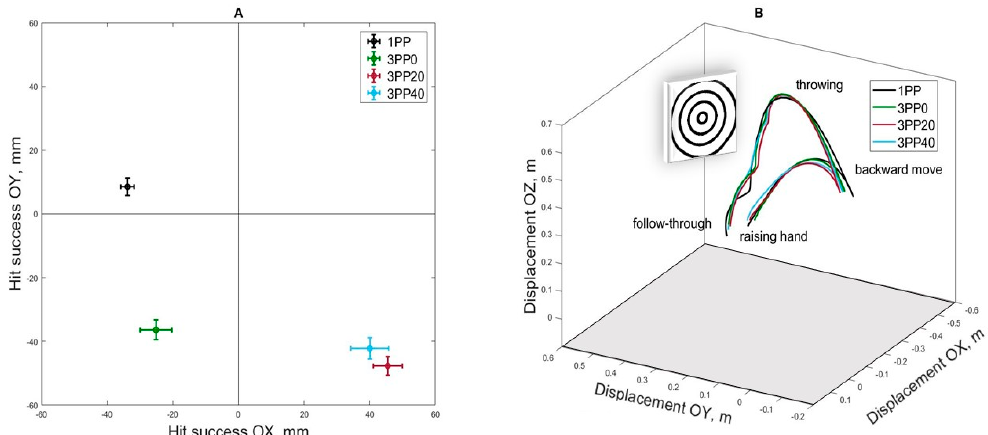
Figure 3. Hit accuracy and hand trajectories during the dart throws. ( A ) Mean hit success in the 1PP, 3PP0, 3PP20 and 3PP40 conditions along the OY and OZ axes and the standard error of the mean (SEM). ( B ) Mean trajectories of the right hand during a throw for four conditions. 1PP—first-person condition, 3PP0—3PPs with 0°, 3PP20—3PP with 20°, 3PP40—3PP with 40°.